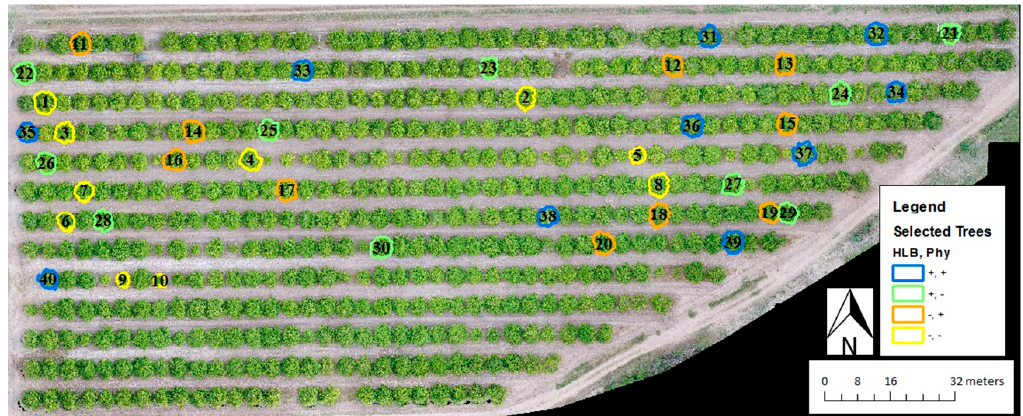
Figure 1. Orthomosaic of selected trees of field conducted using Pix4D Mapper. Numbered trees from 1–10 are HLB and Phytophthora foot rot negative (yellow), 11–20 (orange) are HLB negative and Phytophthora foot rot positive, 21–30 (green) are HLB positive and Phytophthora foot rot negative, and 31–40 (blue) are HLB and Phytophthora foot rot positive.